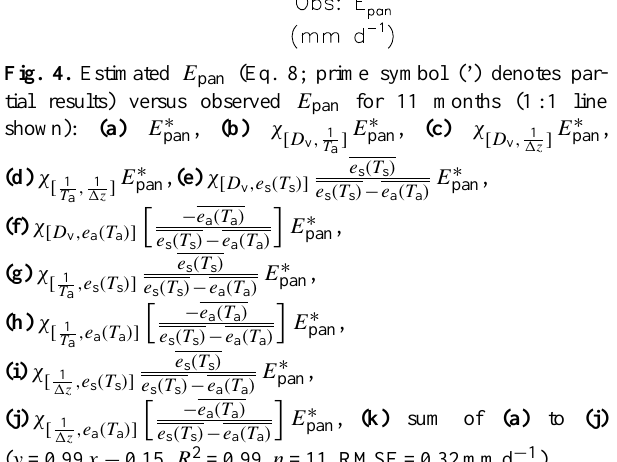
E ∗ pan , (c) χ E ∗ pan , ] [ D v , 1 ] D v , 1 T 1z a